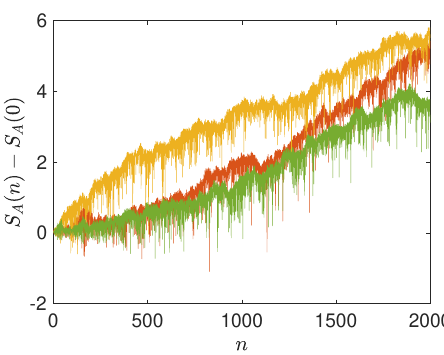
Figure 24: A sample plot of entanglement entropy evolution in the heating phase without performing ensemble average. The driving protocol and parameters are the = same as Fig. 7, with ∆ T / l eff